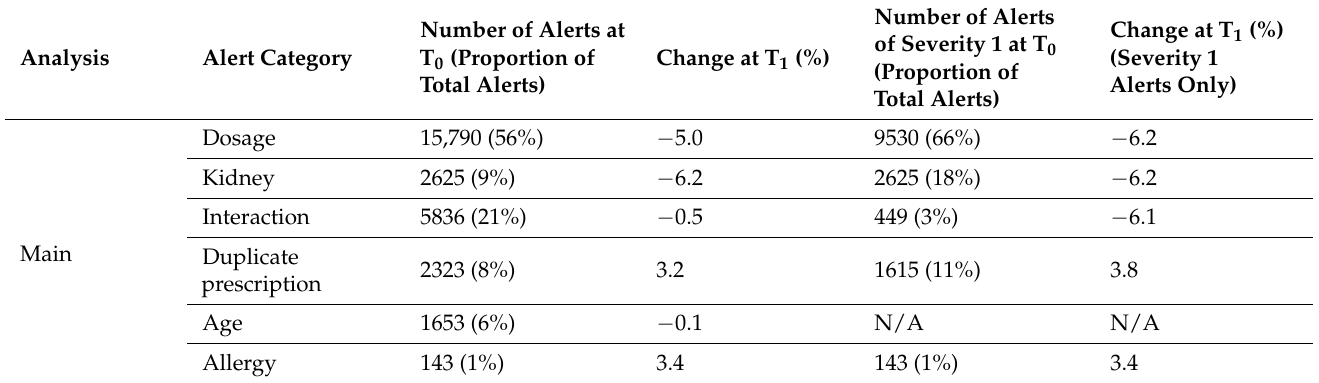
Table 4. Overall number of alerts per category at T 0 and change over the course of the